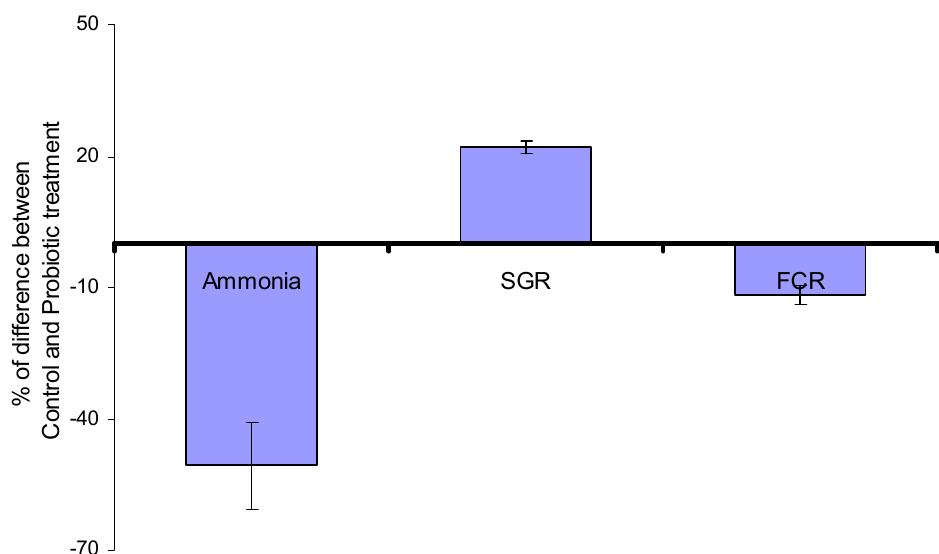
Figure 3. The average percentage change on ammonia (NH 3 ), specific growth rate (SGR), and feed conversion rate (FCR) as reported in peer-reviewed articles describing the effects of probiotics on water quality and growth of Figure 2. Reduction of ammonia (NH 3 ) was 50.75%, growth rate was increased by 17.1%, and the FCR was reduced by 10.7%. Vertical bars indicate ± standard deviation (sd) of the mean ( n = 11).